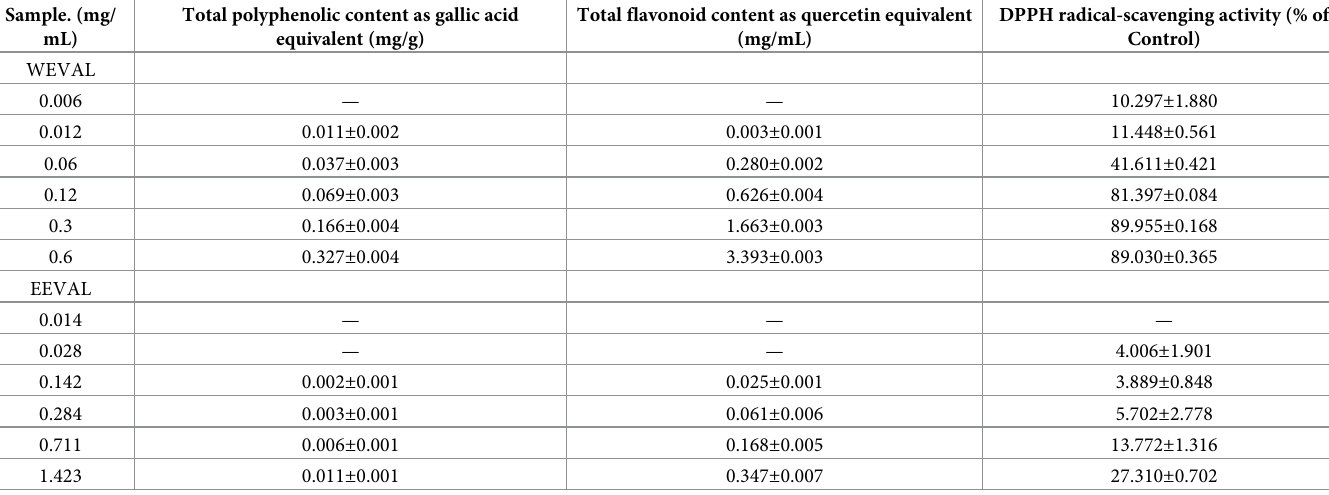
Table 1. Total phenolic contents, flavonoid contents and DPPH radical-scavenging activity of WEVAL and EEVAL. Sample. (mg/ mL)